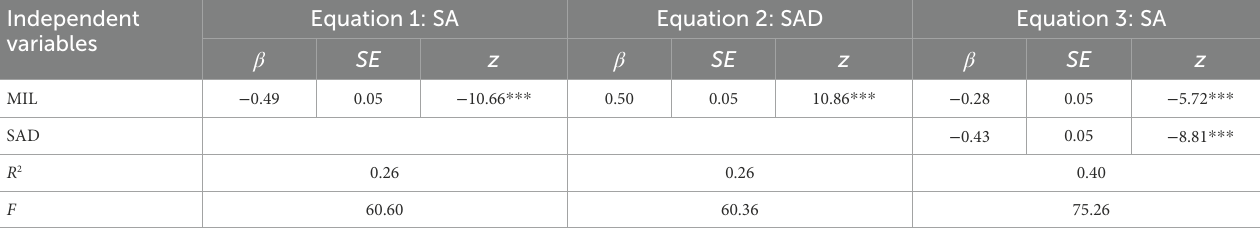
TABLE 3 Testing the mediation effect of school adaptation.